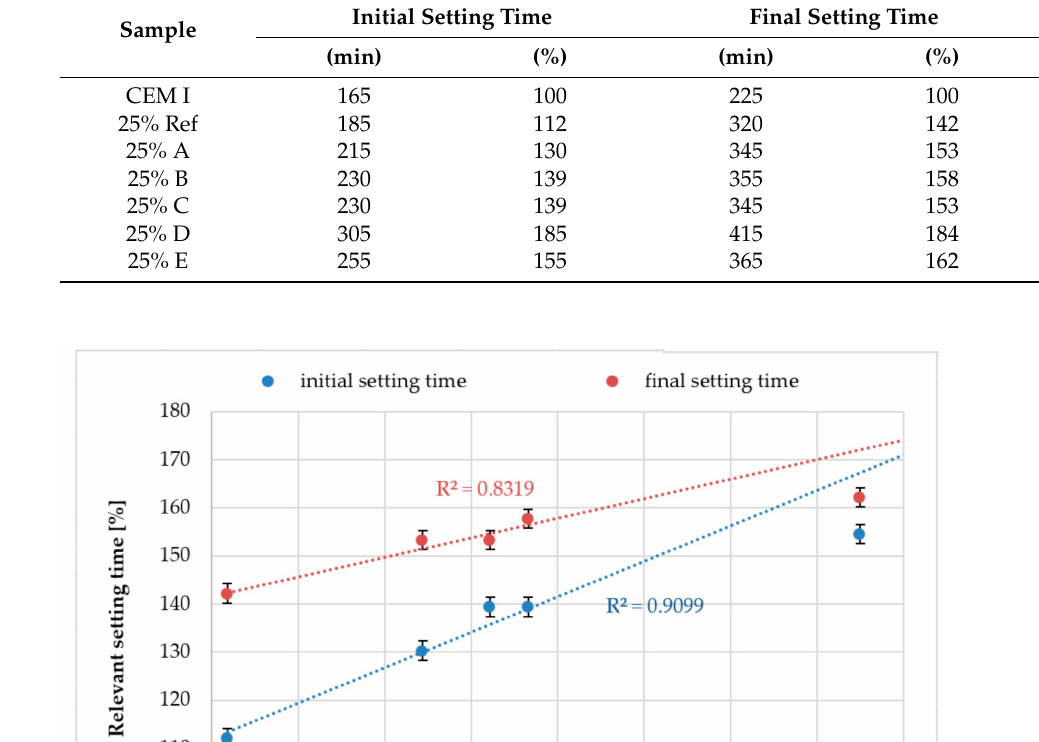
Table 9. Setting time of grouts.